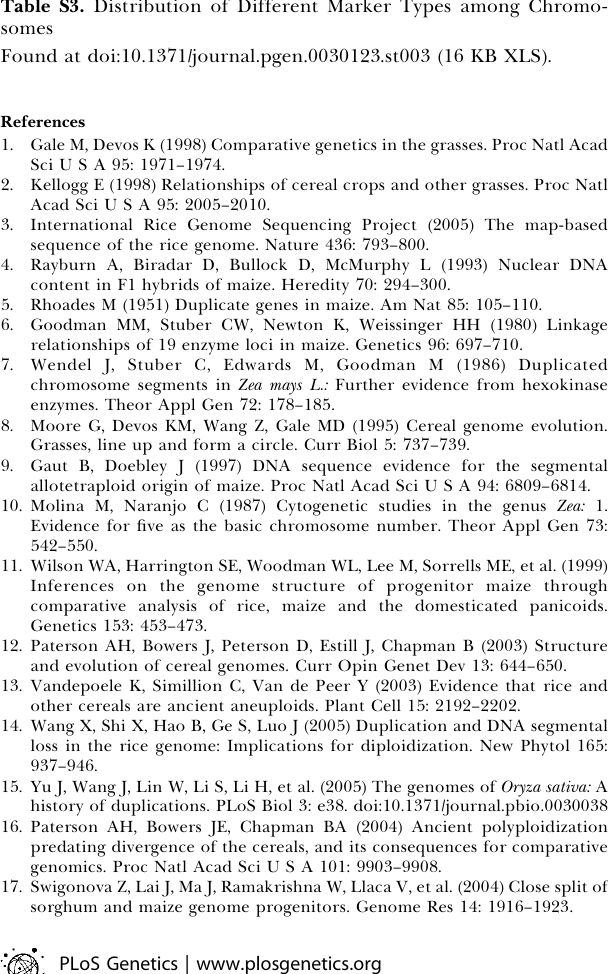
Table S4. Primary Synteny of Maize and Rice Table S5. Chromosomal Fragment Rearrangement after Maize–Rice